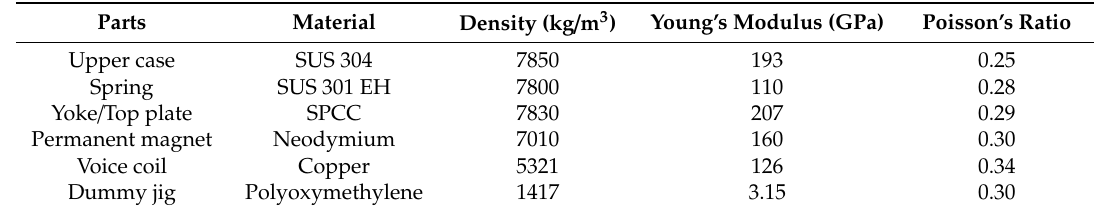
Figure 3. ( a , b ) The measurement method for acceleration of the vibration motor. Table 1. Mechanical properties of the linear vibration motor.